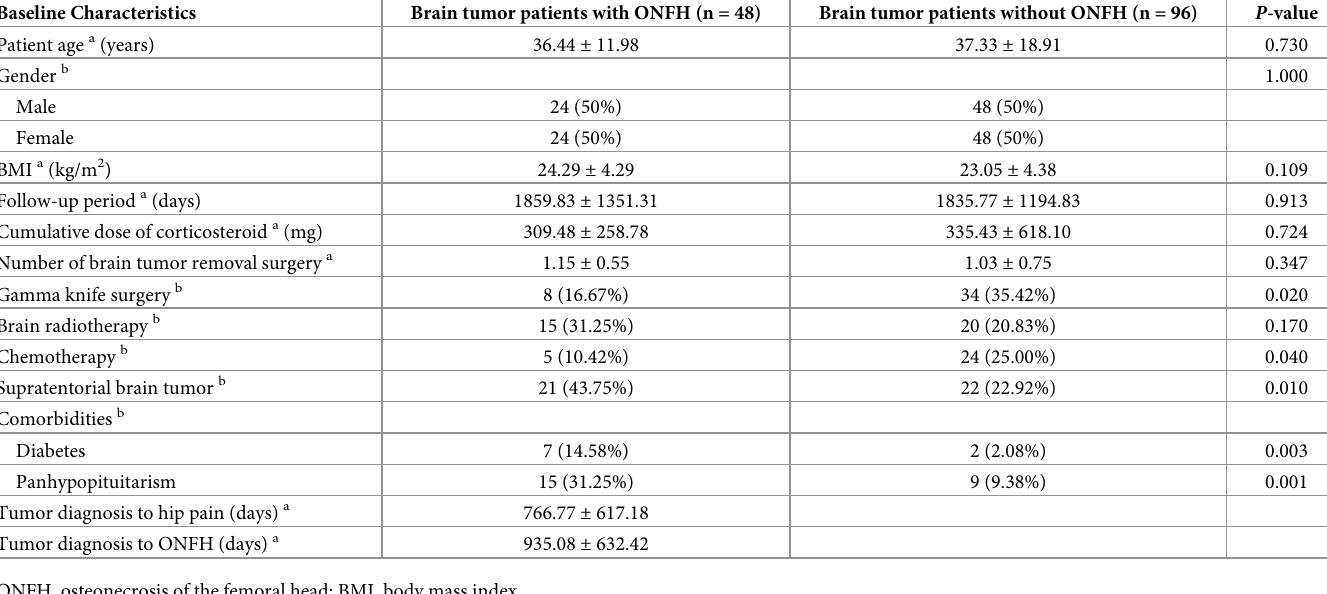
Table 2. Demographic characteristics of the 48 brain tumor patients with ONFH (case) compared to 96 matched brain tumor patients without ONFH (control). Baseline Characteristics